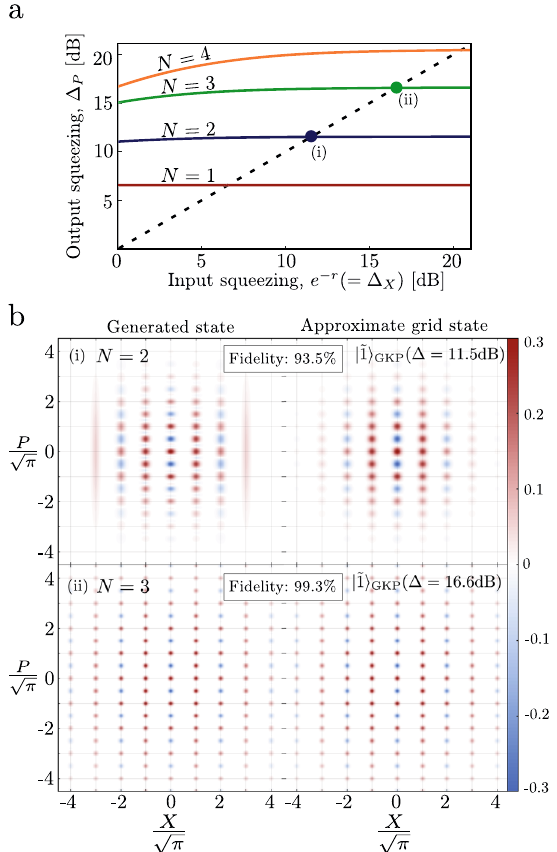
Fig. 2 Quality of states generated with fi nite squeezing. a Effective squeezing in the P quadrature, Δ P , as a function of squeezing in the X -quadrature of the input state after N rounds. Δ X is invariant under the protocol. The dashed line is Δ P = Δ X = e − r . b Left: Wigner functions of the generated states for N = 2 and N = 3 with 11.5 dB and 16.6 dB input squeezing respectively. The plotted states are marked with (i) and (ii) in ( a ). Right: Wigner functions of the target approximate GKP states given by equation (5).